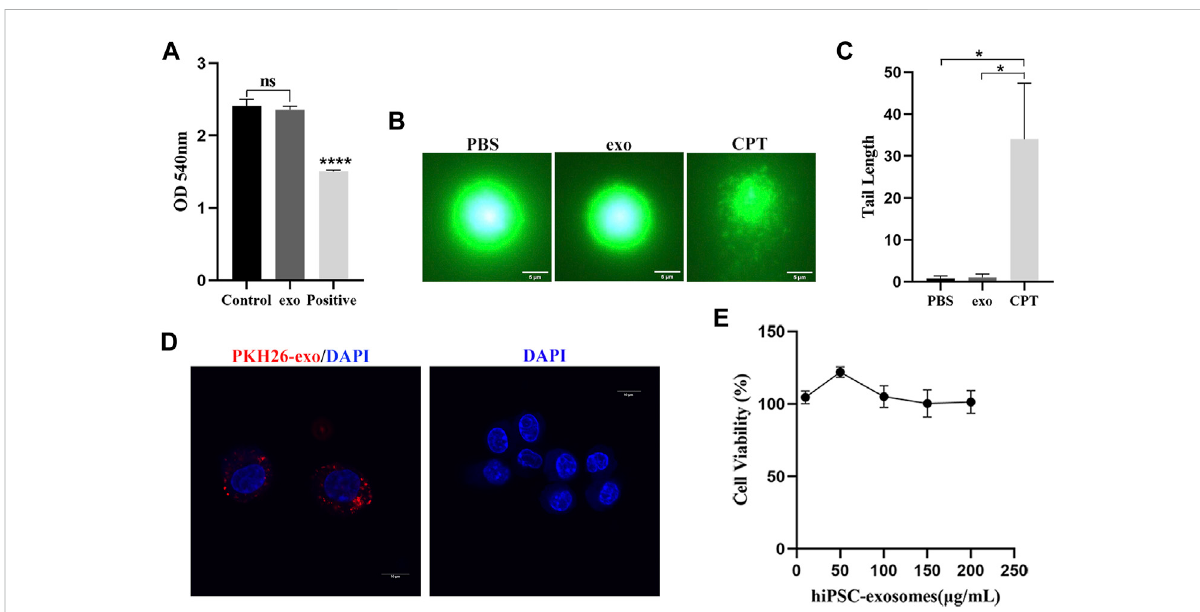
FIGURE 3 Safety evaluation of hiPSC-exosomes at the cellular level. (A) Absorbance values of various groups of erythrocyte suspensions at 540 nm. N = 4 per group (ns, no statistical difference; **** p < 0.0001). (B) Fluorescence image of DNA after alkaline comet electrophoresis of leukocytes in PBS, hiPSC-exosomes,andthe50 μ Mcamptothecingroup. (C) Taillength analysis ofcomets inthethreegroups. N =5pergroup(* p < 0.05). (D) PKH26- labeled hiPSC-exosome uptake by RAW264.7 cells under laser scanning confocal microscopy. (E) Viability of RAW264.7 cells treated with up